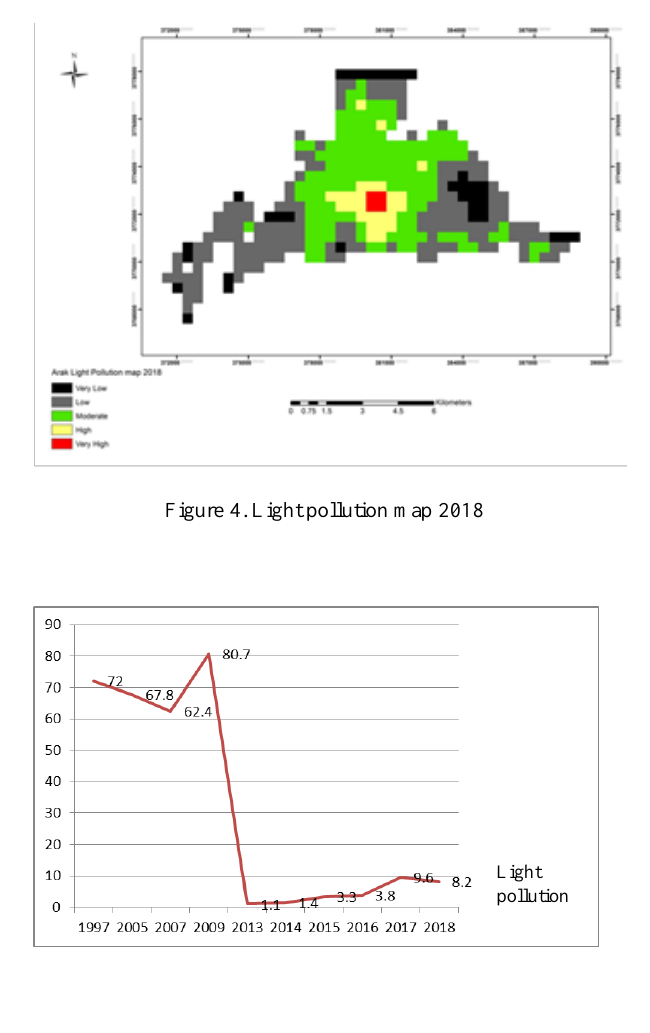
Figure 5. Chart of light pollution from 1997 to